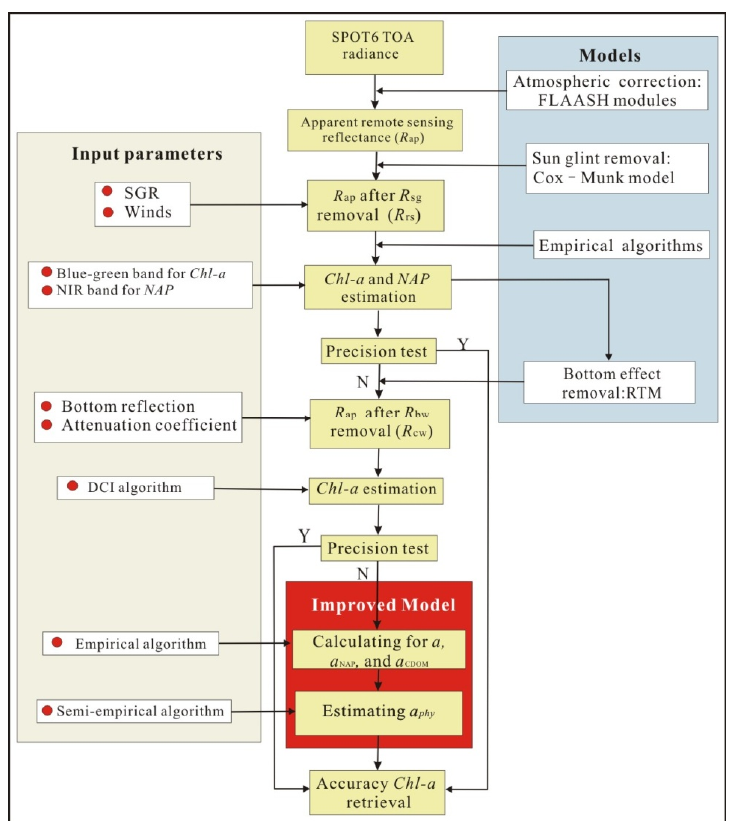
Figure 4. Flow chart of the retrieval algorithm. Chl-a, chlorophyll-a; FLAASH, fast line of sight atmospheric analysis of spectral hypercube; NAP, non-algal particle; NIR, near-infrared; RTM, radiative transfer model; SGR, sun–satellite geometric relationship; TOA, top-of-atmosphere; DCI, difference Chl-a index.